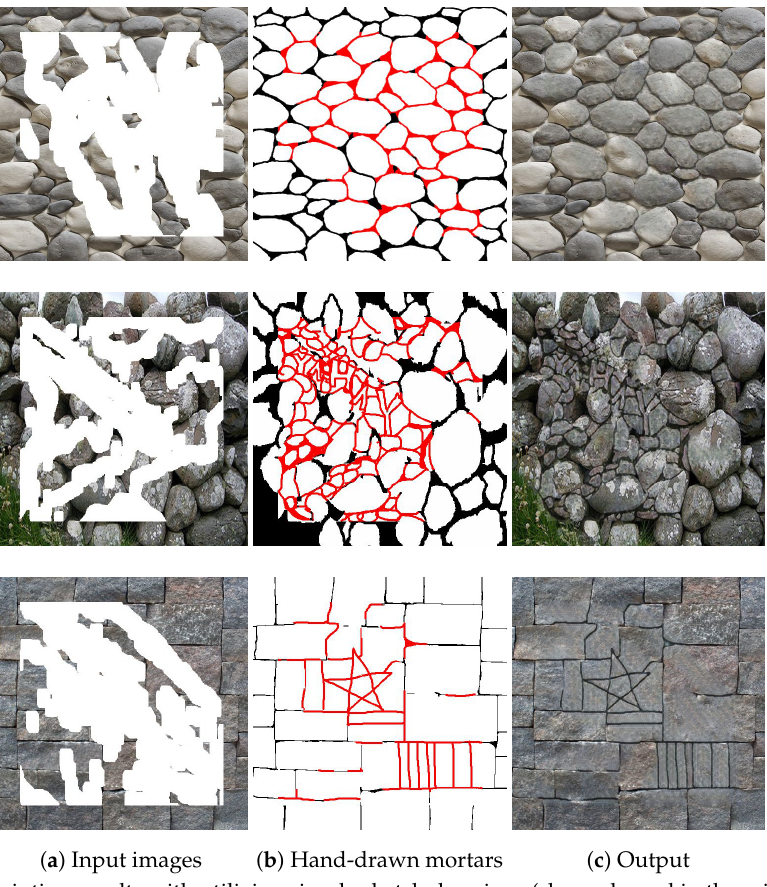
Figure 14. Inpainting results with utilizing simple sketch drawings (shown by red in the middle column) created by experts for mortar structure estimation in the occluded